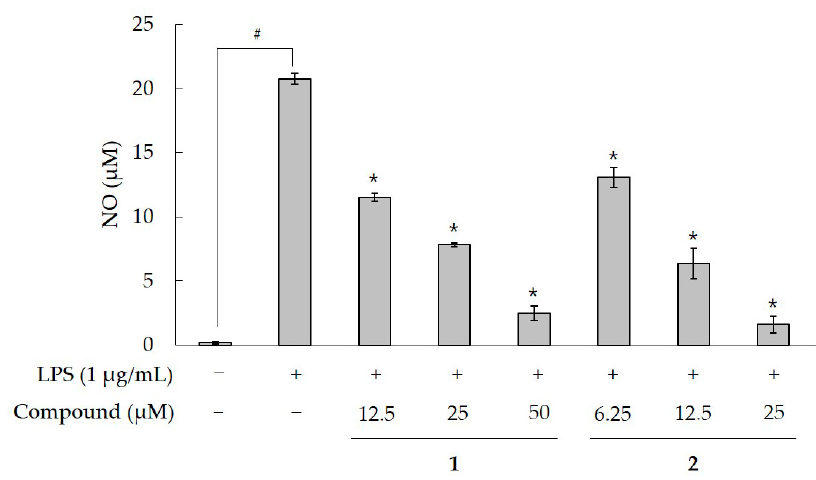
Figure 4. Effects of 1 and 2 on NO production in RAW 264.7 cells. Data are presented as means ± SD